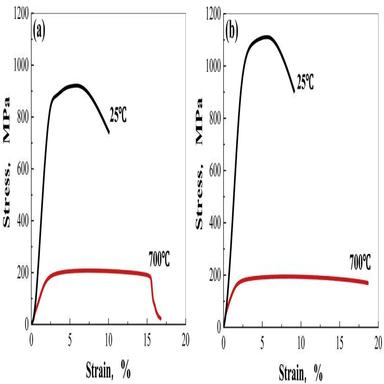
Tensile curves of the novel carbide-free 9Cr-ODS steel tested at RT and 700 ℃: (a) tempered at 750 ℃; (b) tempered at 800 ℃.